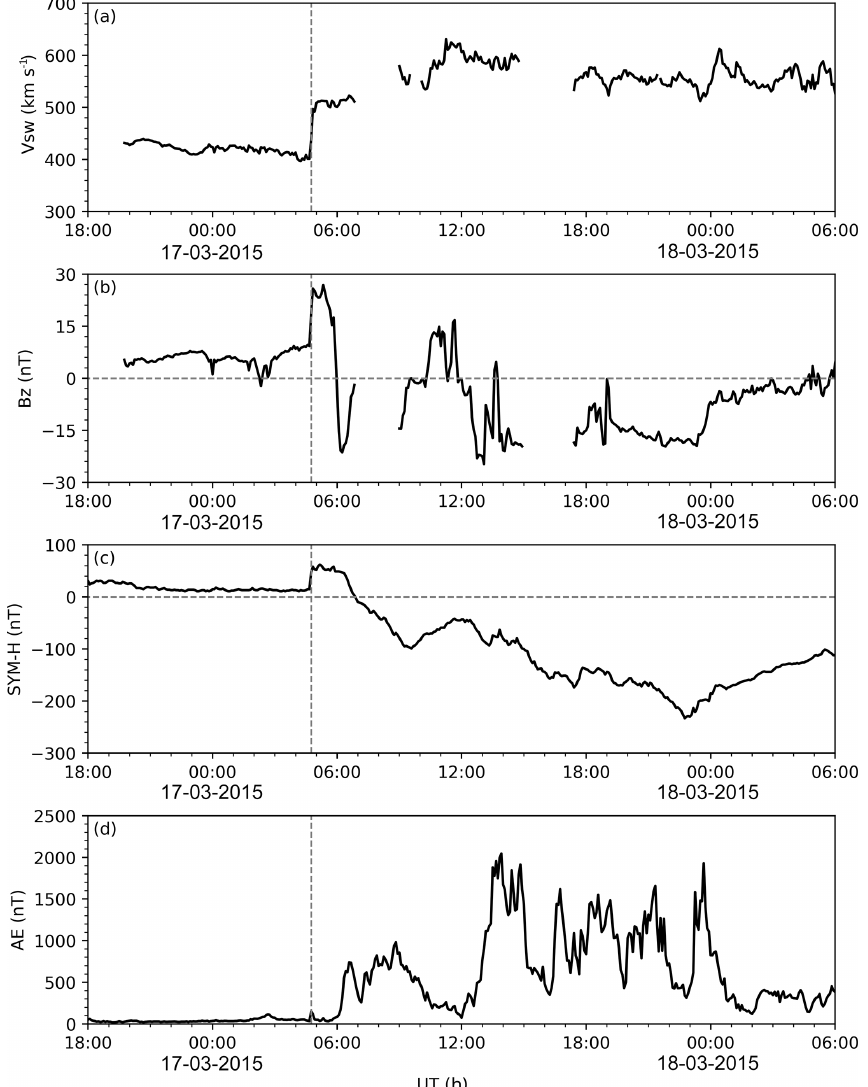
Figure 2. Temporal variations in (a) the solar wind speed ( V sw ), (b) the IMF B z component, (c) the SYM-H index, and (d) the AE index between 18:00UT, 16 March 2015, and 06:00UT, 18 March 2015. The occurrence of SSC is shown with vertical dashed